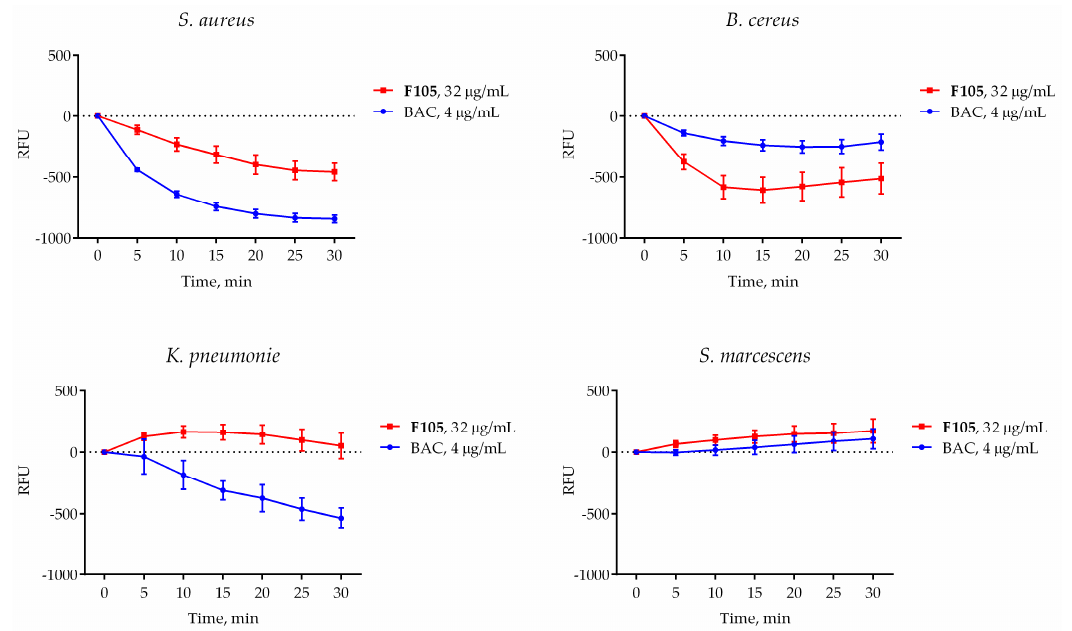
Figure 6. The effect of F105 (blue line) and benzalkonium chloride (red line) on the membrane potential of bacterial cells. Bacteria were grown for 18 h, harvested, and washed with PBS. Cells were re-suspended until the final density of 10 5 CFU/mL in PBS supplemented with DioC 2 (10 µ M). After 30 min preincubation at 25 ◦ C, F105 or BAC were added until final concentrations of 4 or 32 µ g/mL, respectively (corresponding to their respective MBCs), and the fluorescence was measured for 30 min with 5-min intervals. Black dashed line indicates the same data for the untreated control cells.